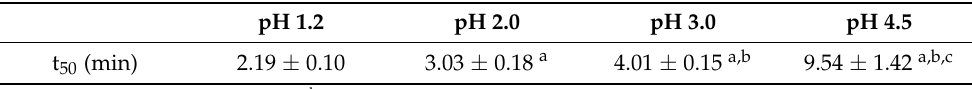
Figure 3. Image area of the coated magnetic tablet versus time for distinct pH mediums employing the MC-ACB ( n = 6). Table 2. The onset of the disintegration process (t 50 ) for distinct pH mediums ( n = 6)